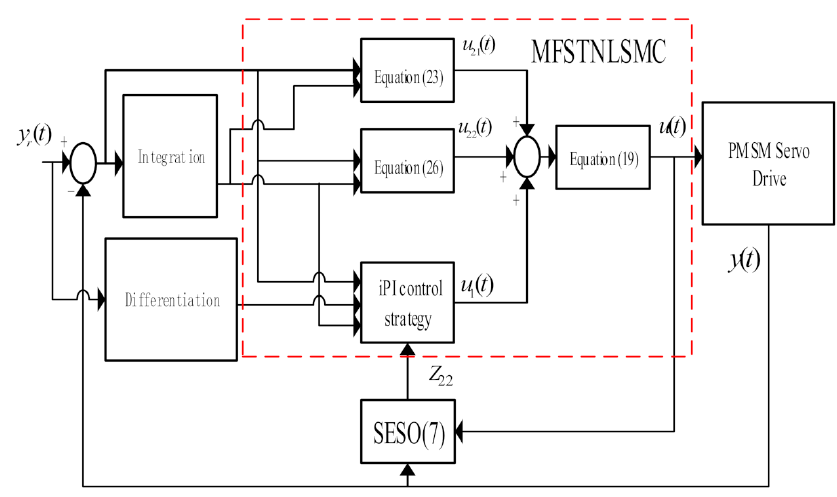
Figure 2. Structure of the proposed MFSTNLSMC strategy with the improved